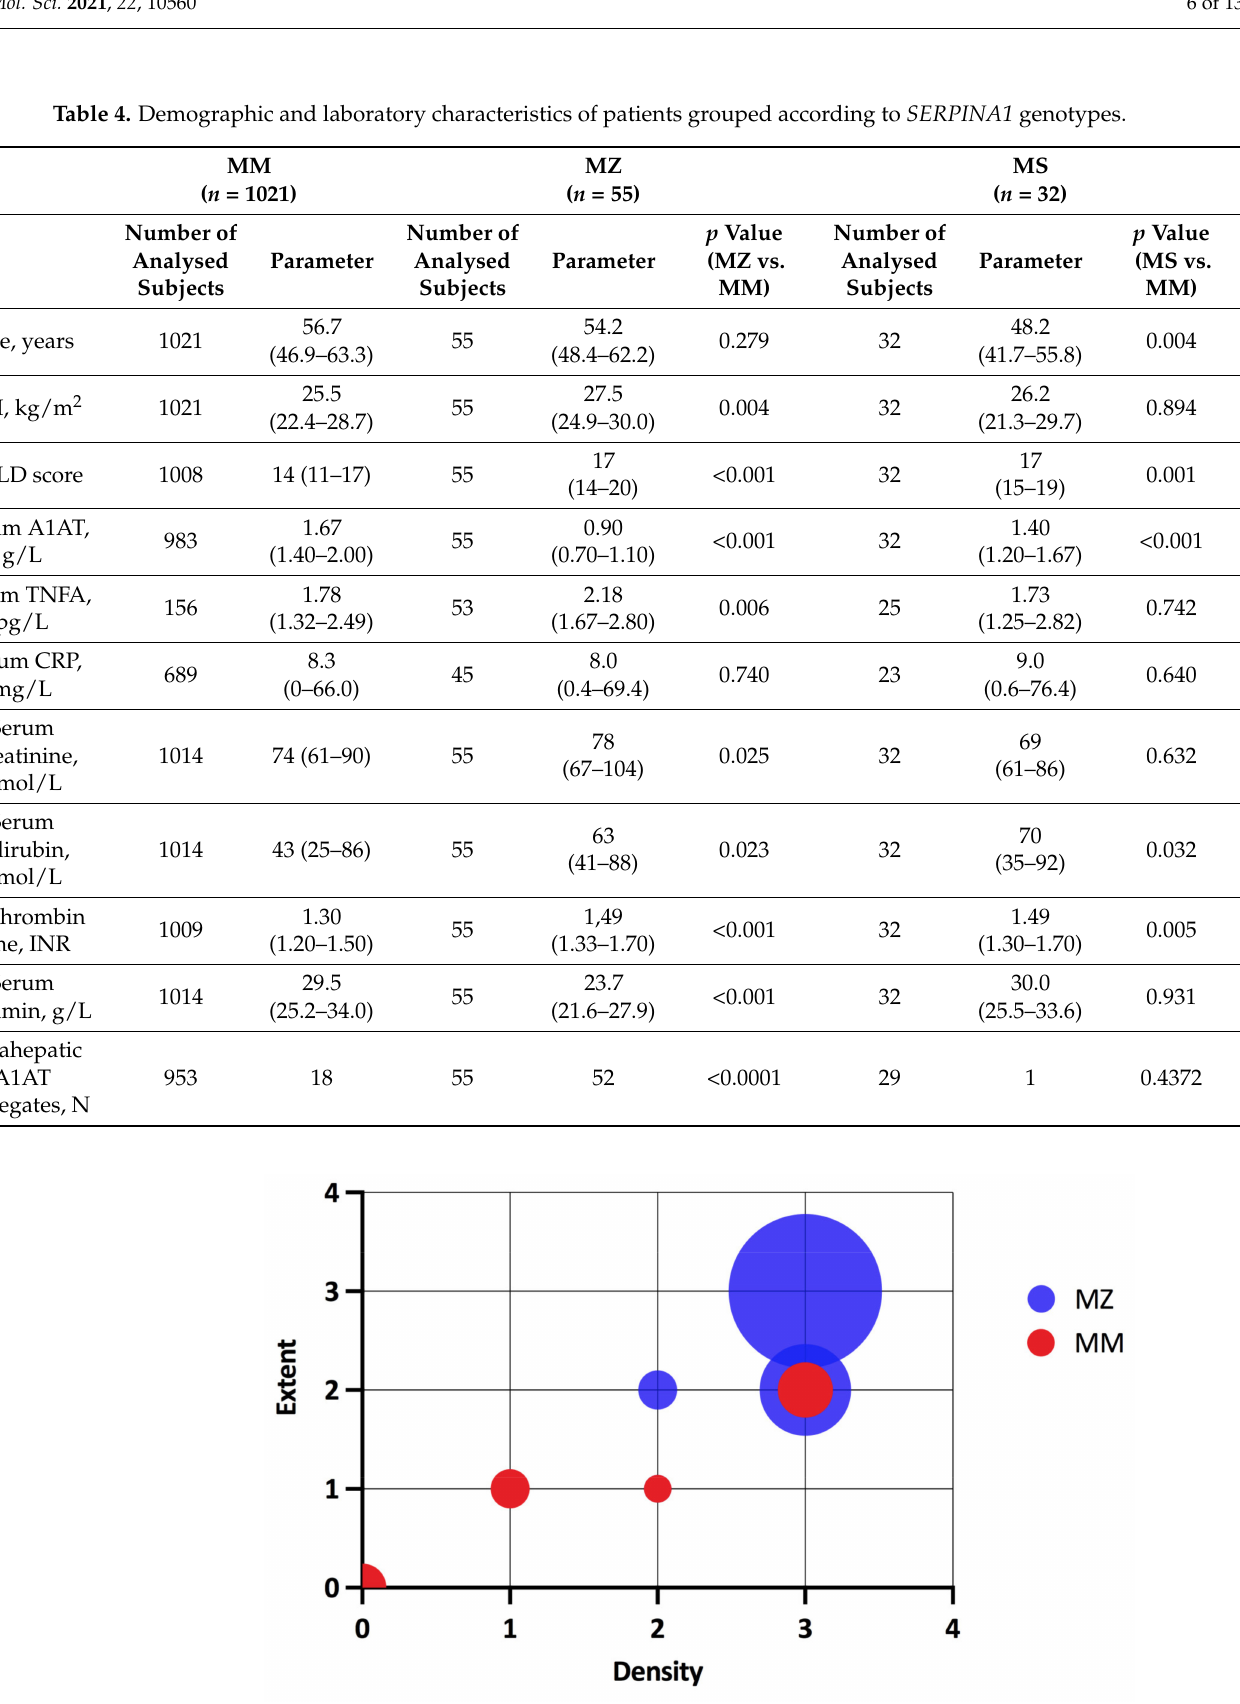
Figure 2. Extent and density of intrahepatic PASD positive aggregates, according to SERPINA1 genotype. PASD, periodic acid–Schiff